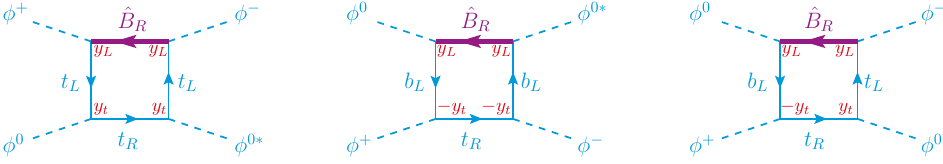
Figure 4 . The one-loop contributions to A [2] ( φ + φ 0 → φ + φ 0 ) from the BM model in eq. (5.9) that are proportional to y 2 y 2 . The coupling of each vertex (up to some common overall phase) is also t L labelled. All external particles are going in.